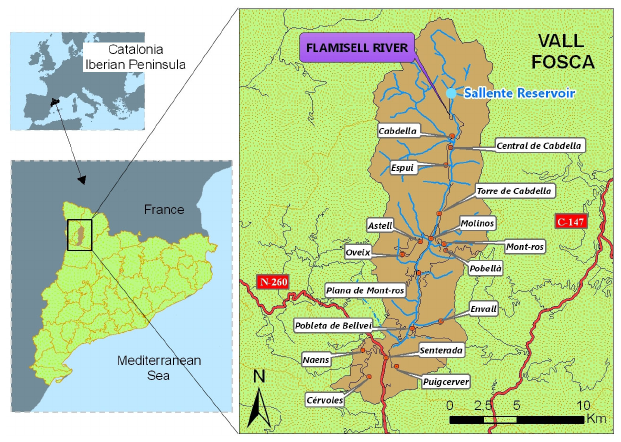
Fig. 1 . Map of the study